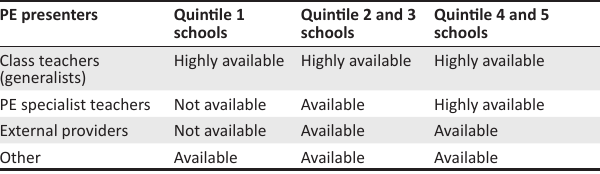
FIGURE 3: Heads of Department and teachers’ years of experience in teaching physical education.